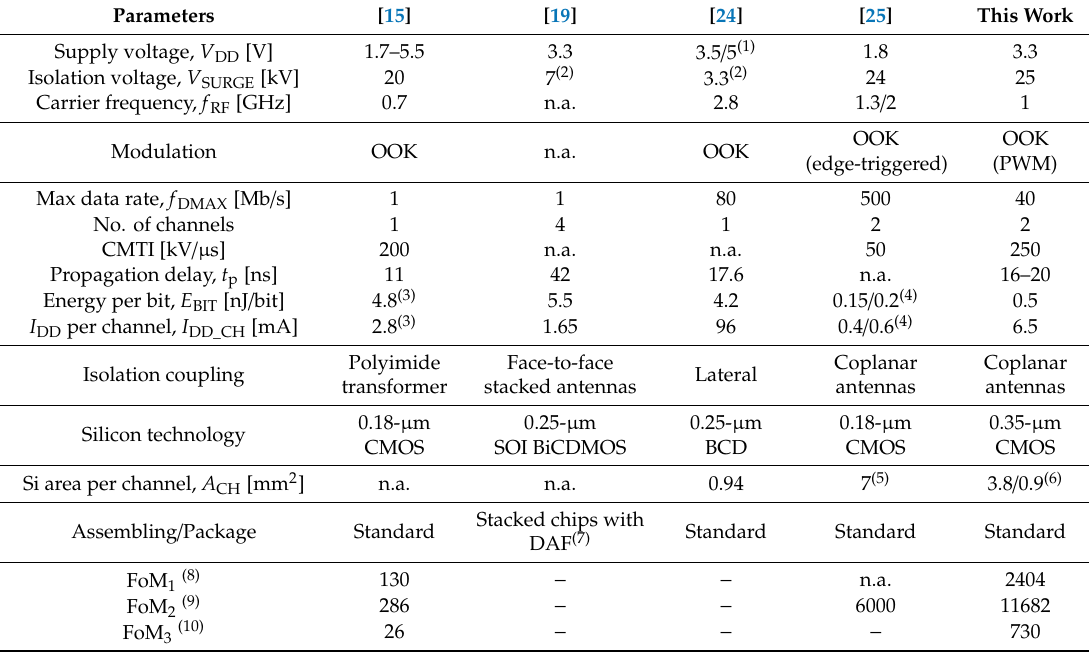
Table 3. Performance summary and comparison with the state-of-the-art of galvanic isolators.